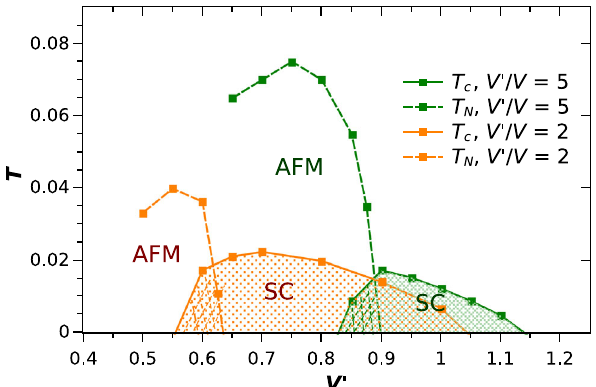
FIG. 4. Phase diagram of the frustrated 2D PAM model within 2 × 2 × 2 DCA at U ¼ 4 . Two groups of results with different V 0 =V ratios are shown. Darker lines (green) are drawn for the more frustrated case ( V 0 =V ¼ 2 ), whereas lighter lines (orange) are for the less frustrated case ( V 0 =V ¼ 5 ). The Néel temperature T (dashed lines) and the superconducting T (full lines) are N c drawn where the respective order parameters vanish. For both values of V 0 =V there is a uniform coexistence region indicated by